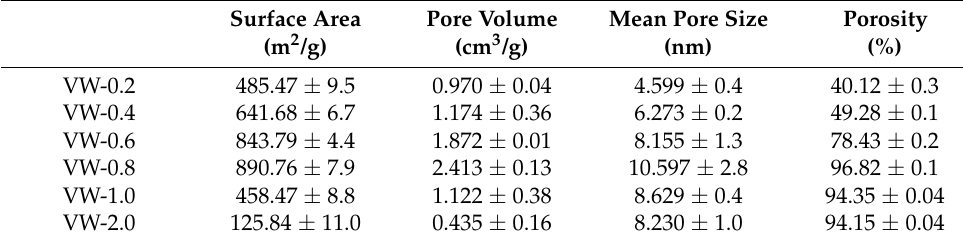
Table 2. Physicochemical properties of the different samples.